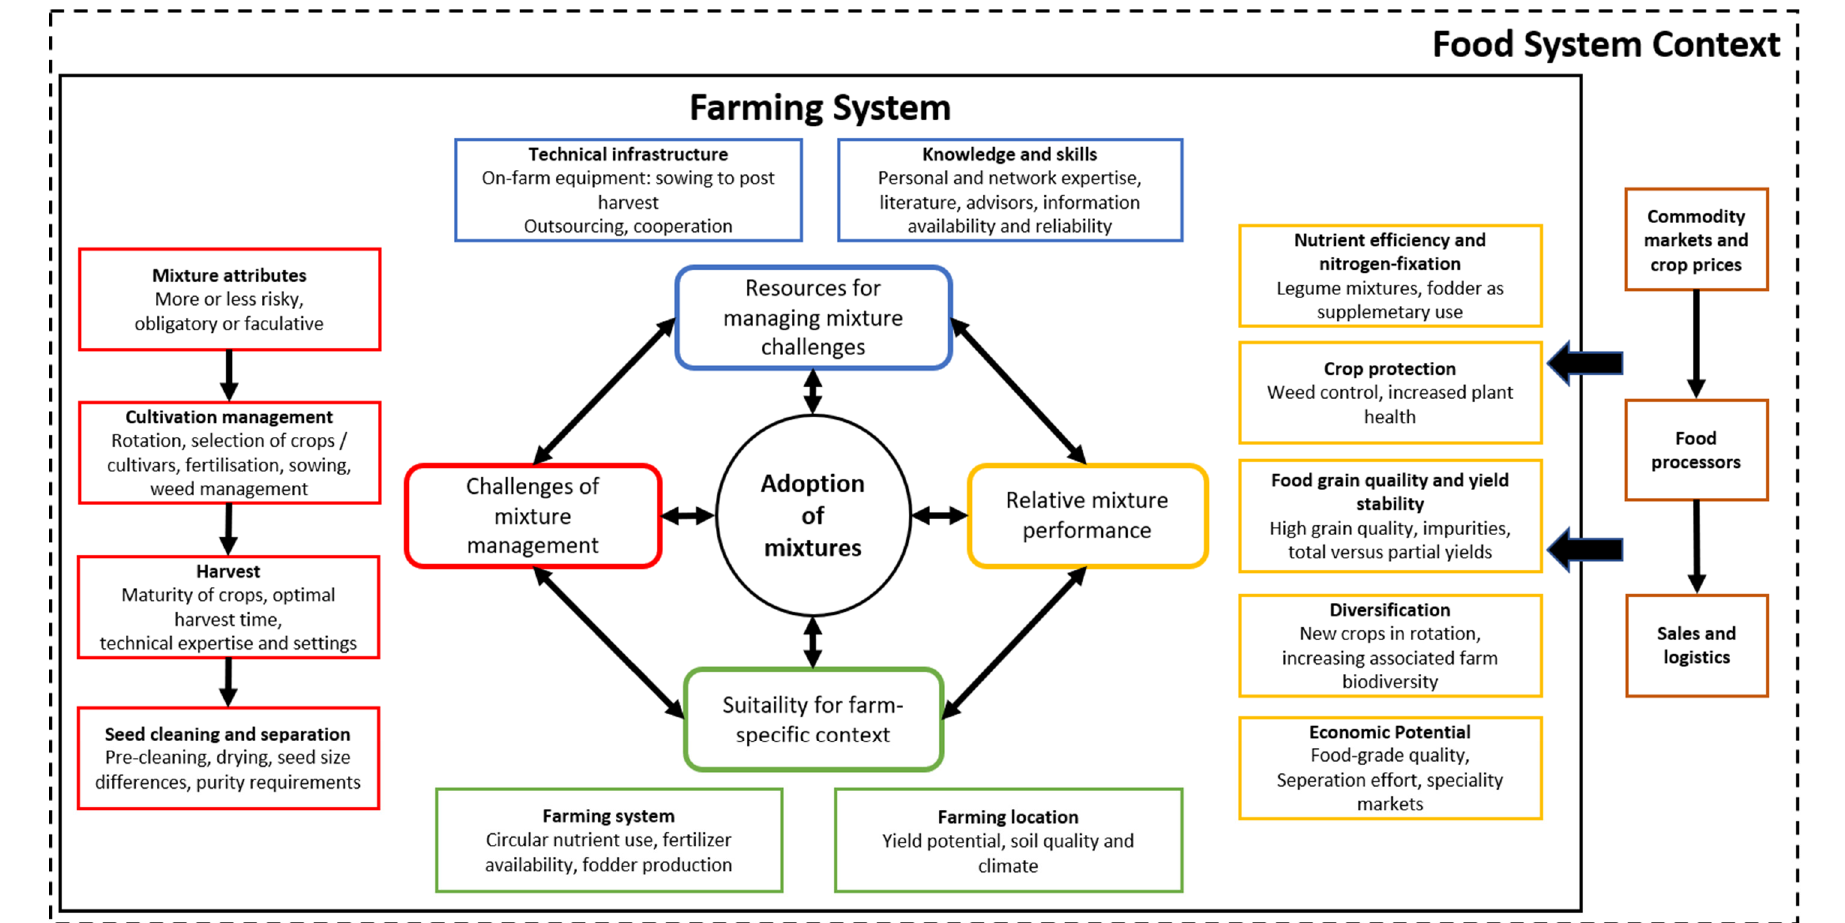
Figure 2. Social representation of the main factors and their interactions influencing species mixture adoption for food grain production within a broader food system context. The social representation was interpretatively reconstructed from the interviews with farmers.